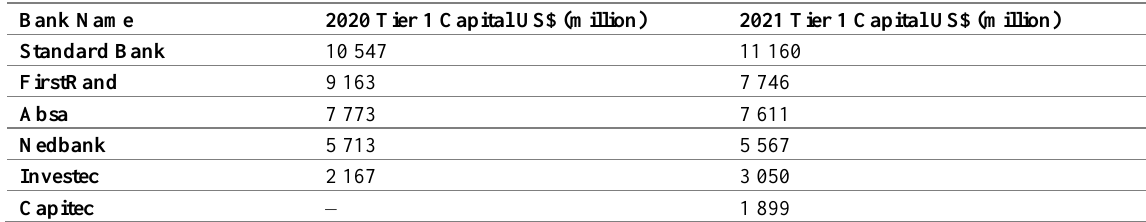
Table 1: South African’s Biggest banks in